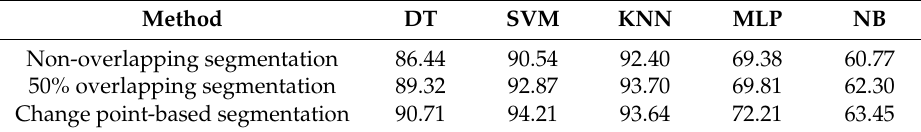
Table 3. Performance evaluation for the change point-based segmentation